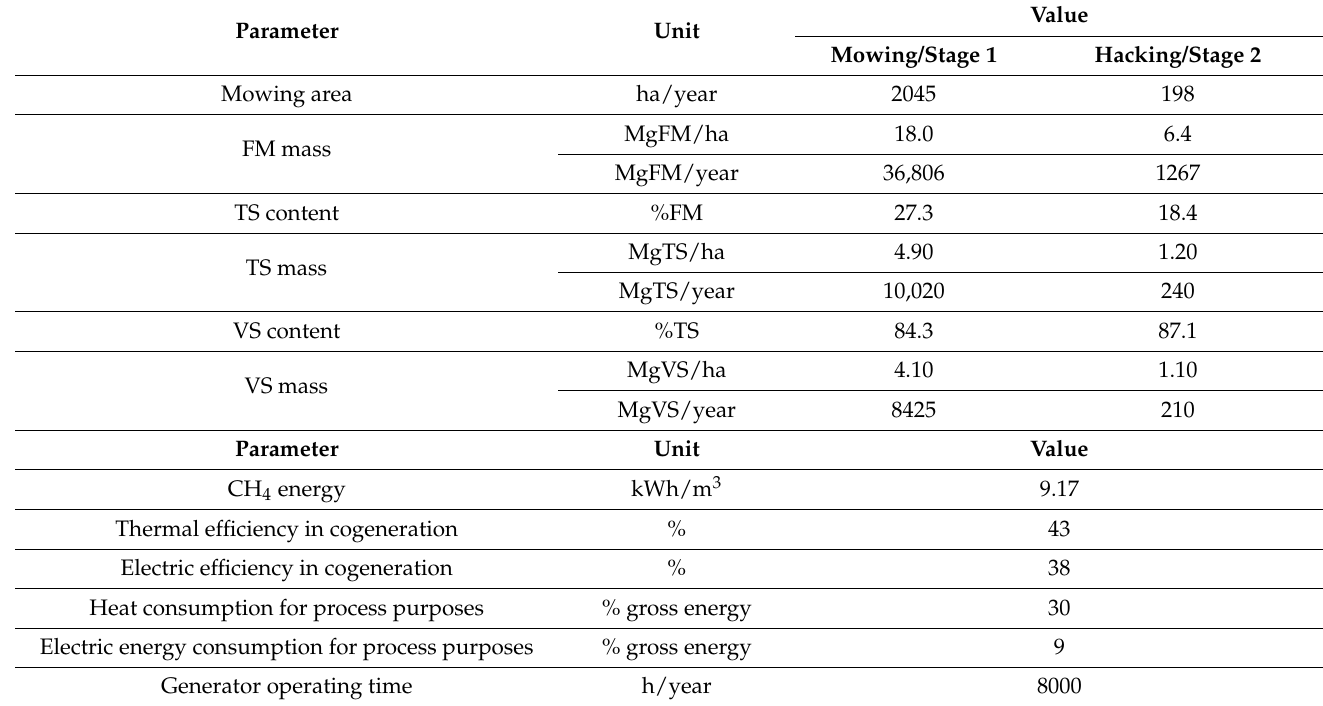
Table 4. The input data for the mass–energy balance.